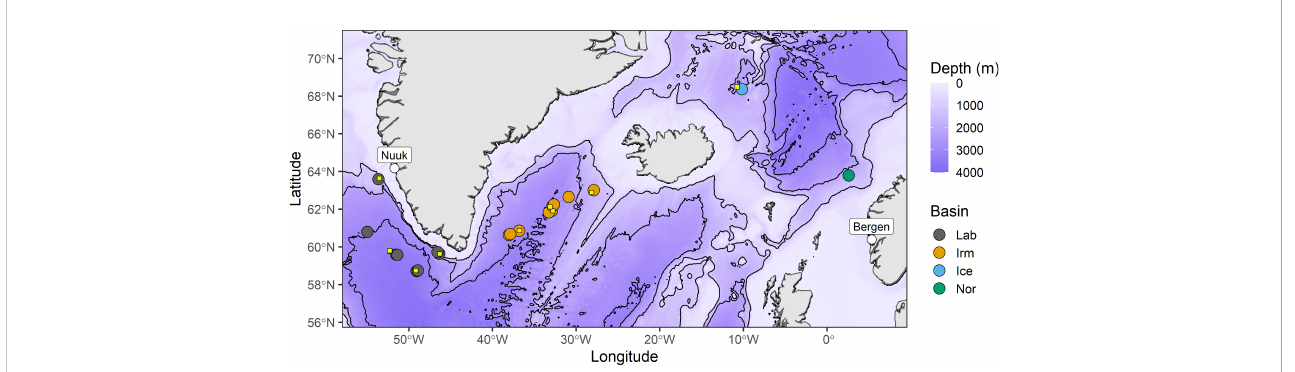
FIGURE 1 Map of the surveyed area from the Euro-BASIN expedition in May-June 2013. Coloured circles denote trawl stations from which fi sh stomachs were collected and processed. Small yellow squares show the position of the MOCNESS sampling stations that subsequently were used to calculate Ivlev ’ s electivity indices for Benthosema glaciale prey items (see section